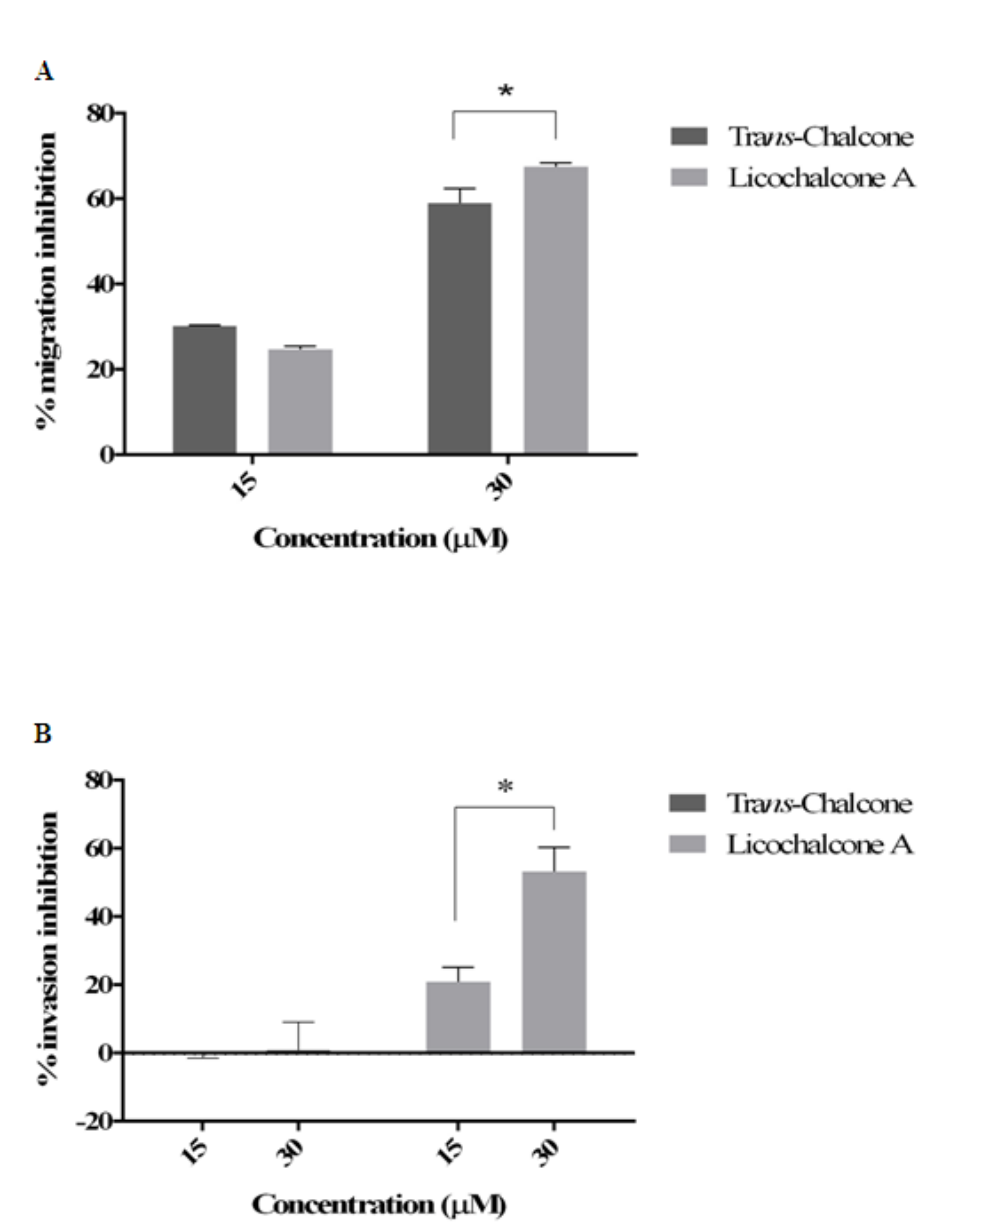
Figure 4. Trans -chalcone e Licochalcone A inhibited cell migration and invasion in BT-20 cells. ( A ) Migration Inhibition (%) and ( B ) Invasion Inhibition (%) both experiments were calculated and quantitative results are illustrates bellow. The data represent the mean ± SD of three experiments. * p ≤ 0.05.